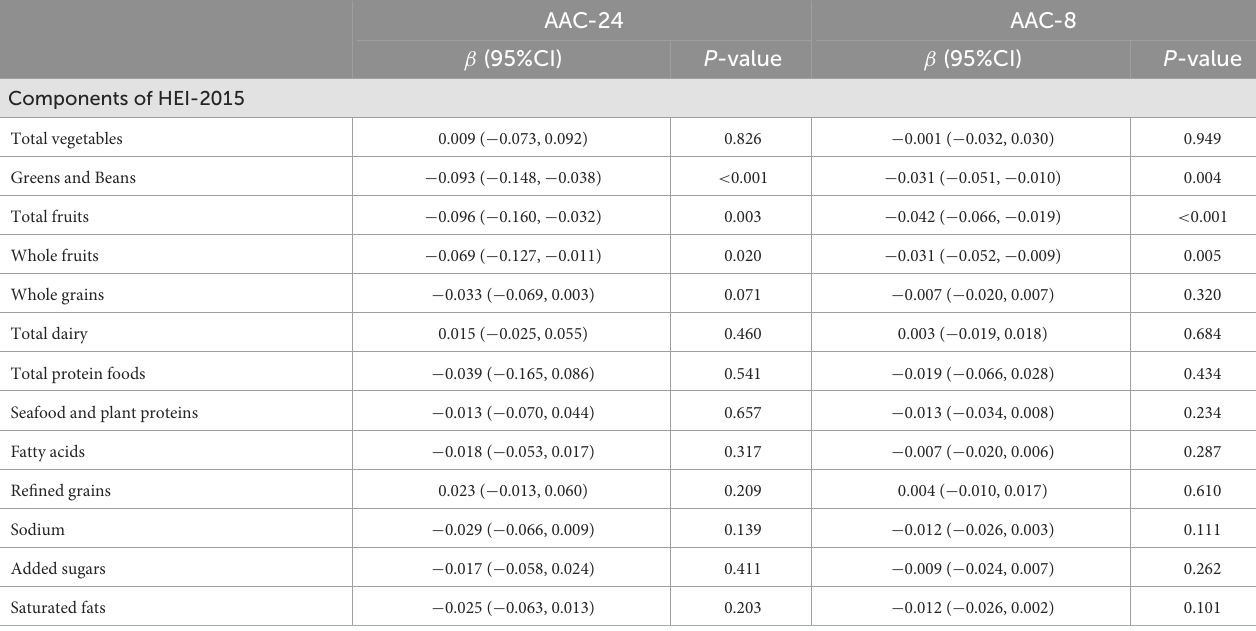
TABLE 3 Associations between components of HEI-2015 and AAC